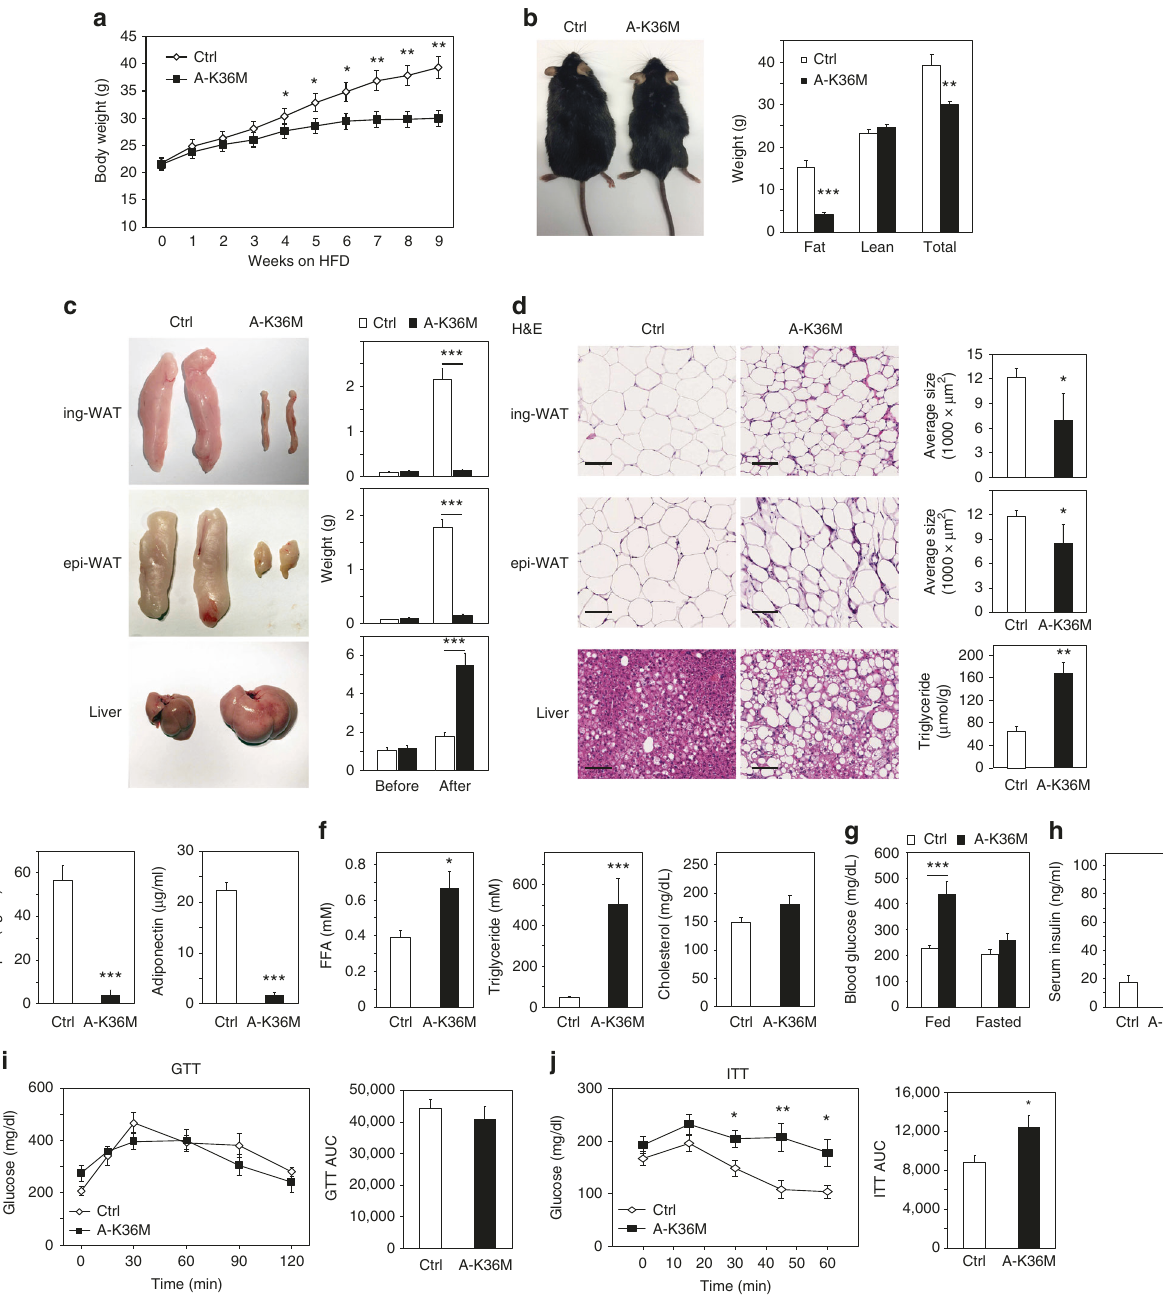
Fig. 7 Mice with adipose-selective expression of H3.3K36M are resistant to HFD-induced WAT expansion. Male Ctrl and A-K36M mice ( n = 6 per group) were fed with high fat diet (HFD) for 10 to 11 weeks starting from the 9th week of age. a Body weight during HFD feeding. b Representative picture of mice after HFD feeding (left). Fat mass, lean mass, and total body weight were measured by MRI (right). c Representative pictures of ing-WAT, epi-WAT, and liver (left panels). Average tissue weights are shown in right panels. before: tissue weights of 8-week-old mice fed with regular diet; after: tissue weights of mice after HFD. d H&E staining of ing-WAT, epi-WAT, and liver (left panels). Scale bar = 100 µ m. Average sizes of adipocytes in ing-WAT and epi-WAT, and the liver triglyceride contents are shown on the right. e Serum leptin (left) and adiponectin (right) levels. f Serum levels of FFA, triglyceride, and cholesterol. g Fed or fasted blood glucose levels. h Serum insulin levels. i GTT. AUC is shown on the right. j ITT. AUC is shown on the right. All values are presented as mean ± SEM. Statistical comparison between groups was performed using Student ’ s t test. * p < 0.05, ** p < 0.01, and *** p <